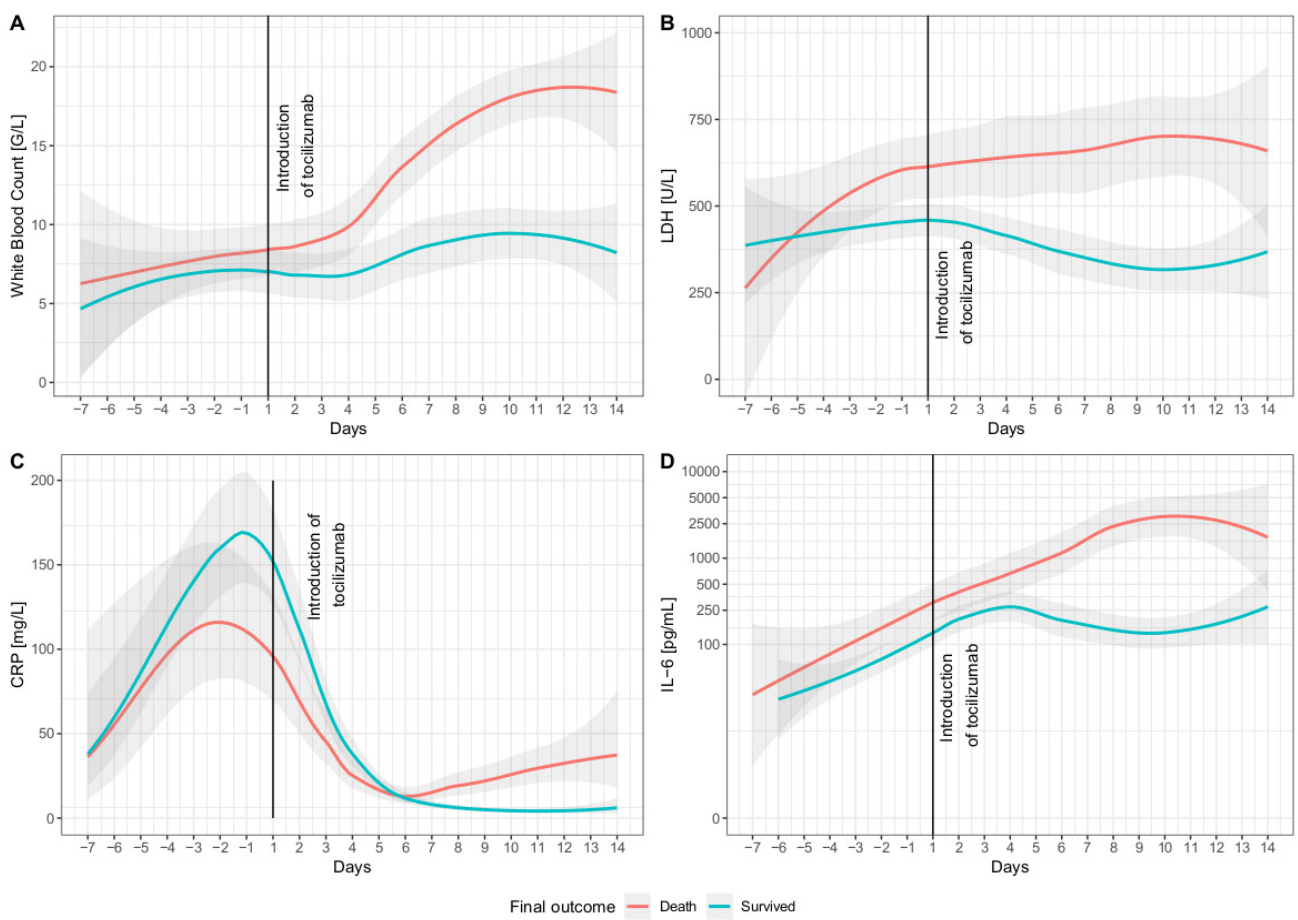
Figure 1. Trends in concentrations of inflammatory markers in serum 7 days before and 14 days after administration of tocilizumab. All charts are presented in linear X-scale, except for chart ( D ), which is presented in log10 scale. ( A ) White blood count; ( B ) lactate dehydrogenase (LDH); ( C ) C-reactive protein (CRP); ( D ) interleukin-6 (IL-6).